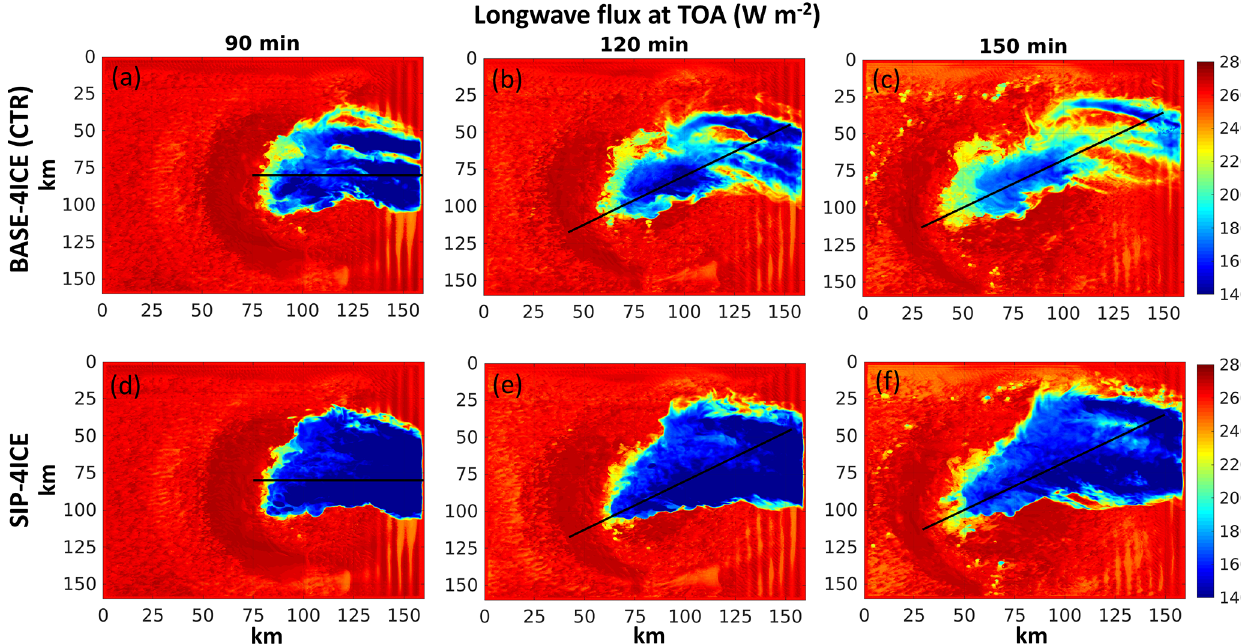
Figure 10. Longwave flux at the top of atmosphere for (a–c) the simulation with the baseline GEM set-up with four free categories of ice at 60, 120, and 180min after the initiation. Panels (d) – (f) are the same as panels (a) – (c) but for the simulation with SIP implemented. Black lines indicate the location of the cross sections shown in later results.